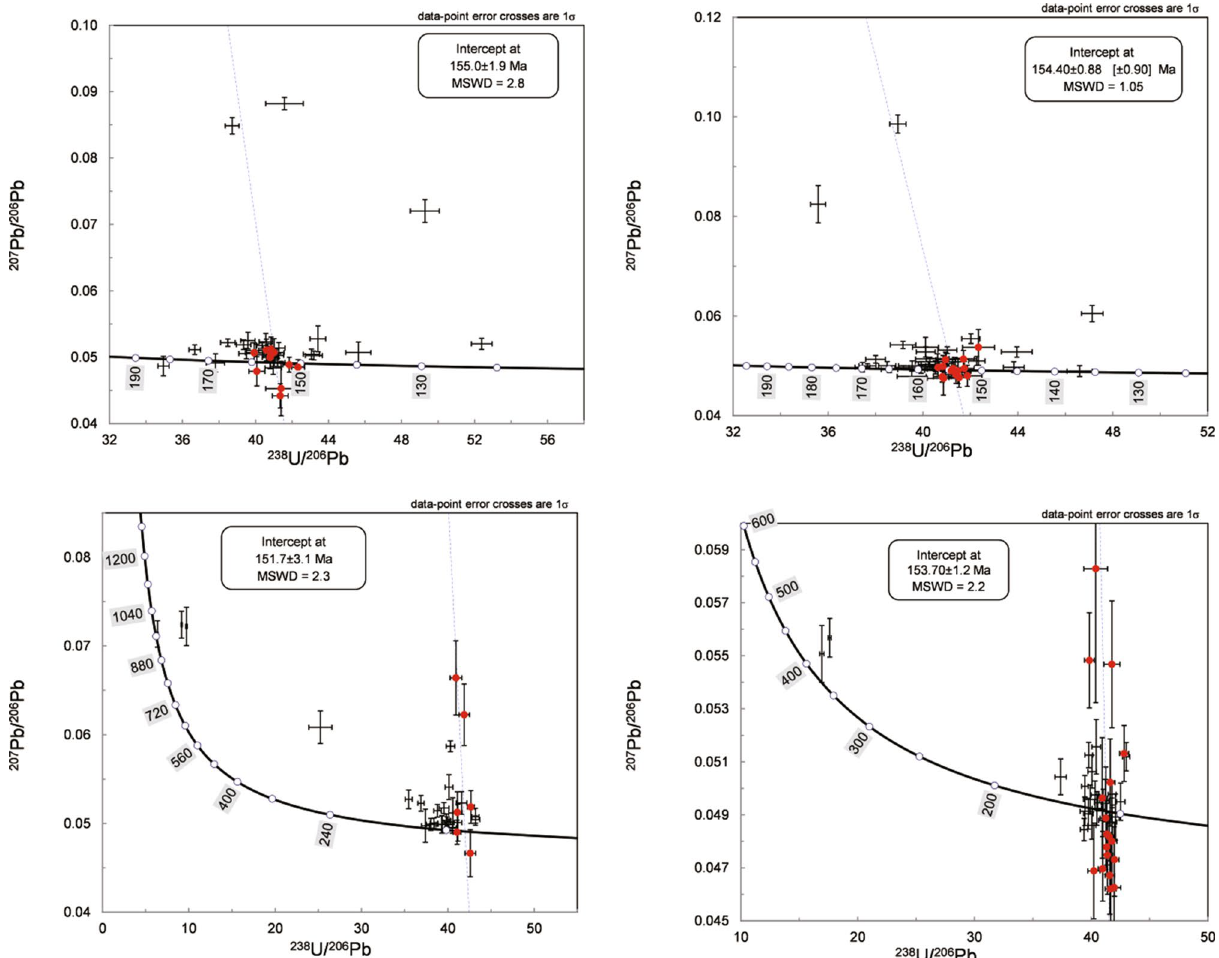
Figure 6. Zircon LA-ICP-MS U–Pb concordia diagrams for the QGC. The data from Sample 490 are too distributed to constrain either intercept age or concordant age. Data processing was carried out using concordia intercept ages on the Tera-Wasserburg plot utilizing ISOPLOT (Ludwig, v. 3.75, 2012, copyright@ BGC Berkeley Geochronology Center, 2006, available from: http://www.bgc.org/isopl ot_etc/isopl